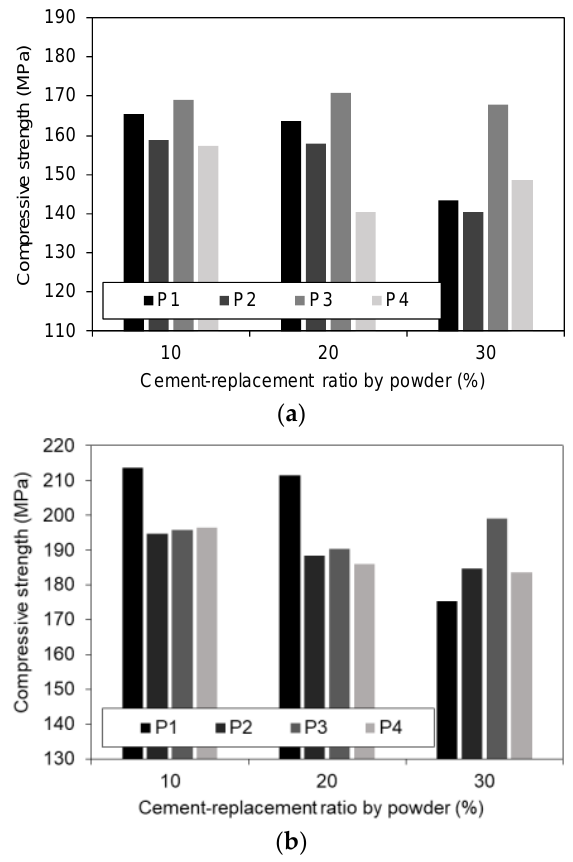
Figure 16. Effect of P/B on compressive strength. ( a ) Seven days. ( b ) Twenty-eight days.